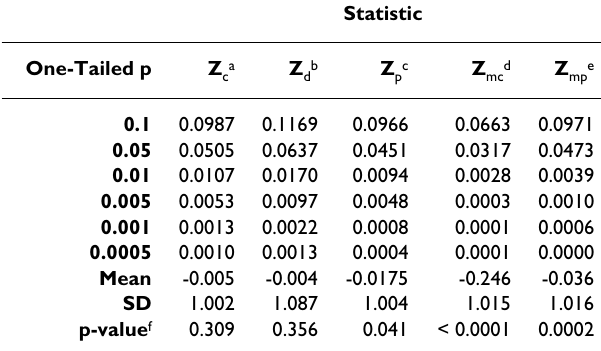
Table 2: Simulation results